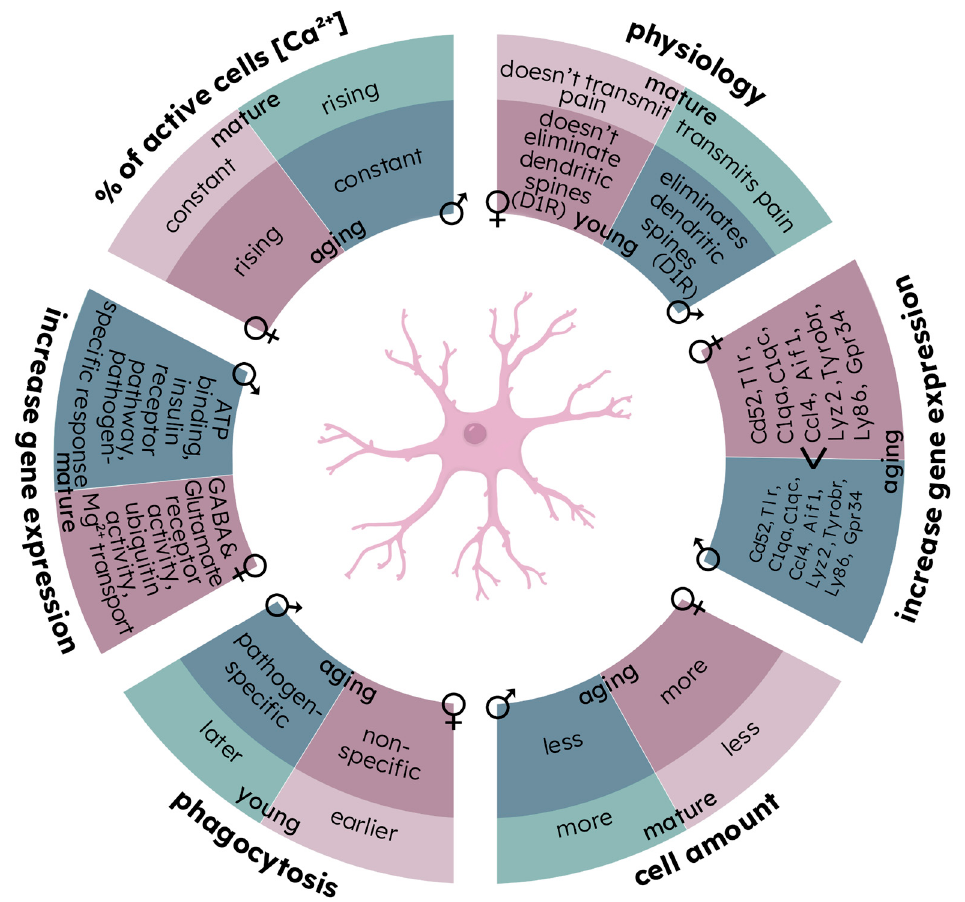
Figure 3. Sex-dependent differences in structure and function of microglia during normal devel- opment. During age, phagocytic activity changes: in females, phagocytic activity appears earlier than in males and unspecific phagocytosis increases with age significantly. However, in males, only pathogen-associated phagocytosis increased with age. At young ages among males, microglial cells participate in the elimination of dendritic spines containing D1 receptors, and in adult age in nociceptive transmission in the spinal cord, whereas in females microglia do not participate in